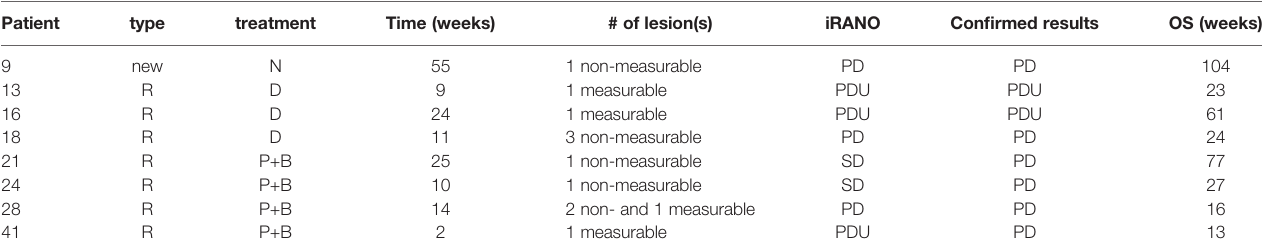
TABLE 5 | Characteristics of new lesions during